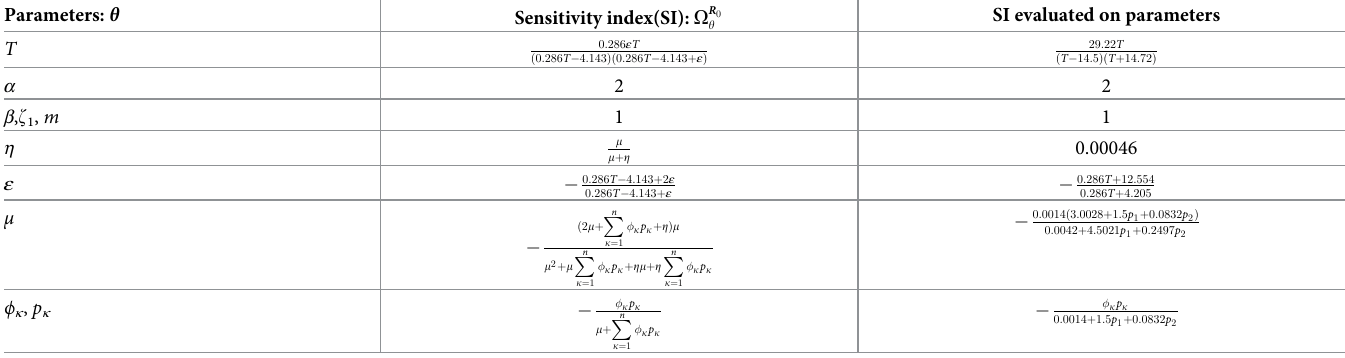
Table 3. Sensitivity indices of R 0 to the malaria model parameters evaluated at the baseline parameter values given in Table 2. Parameters: θ Sensitivity index(SI): O R 0